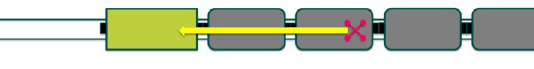
Fig. 8. The convergence process of wagons.